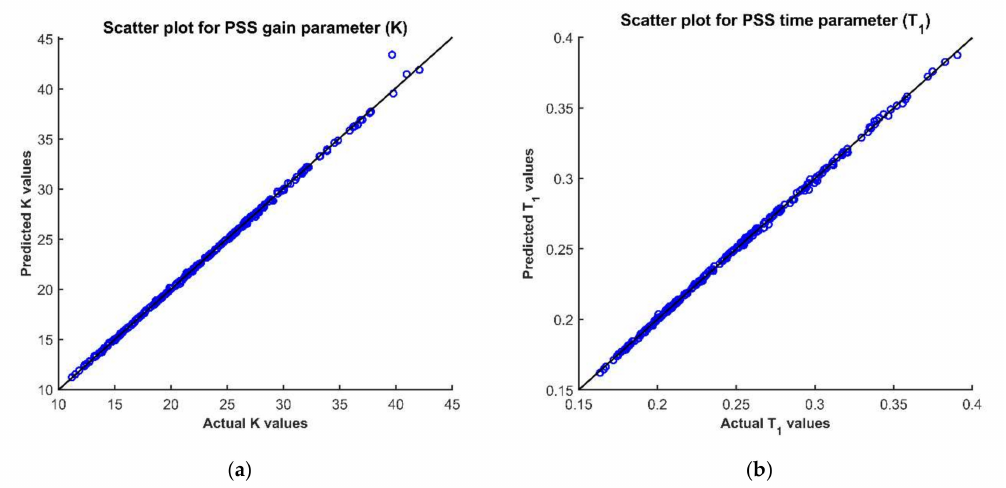
Figure 7. Scatter plots for the PSS key parameters of the first network test datasets; ( a ) PSS gain parameter ( K ) and ( b ) PSS time constant parameter ( T 1